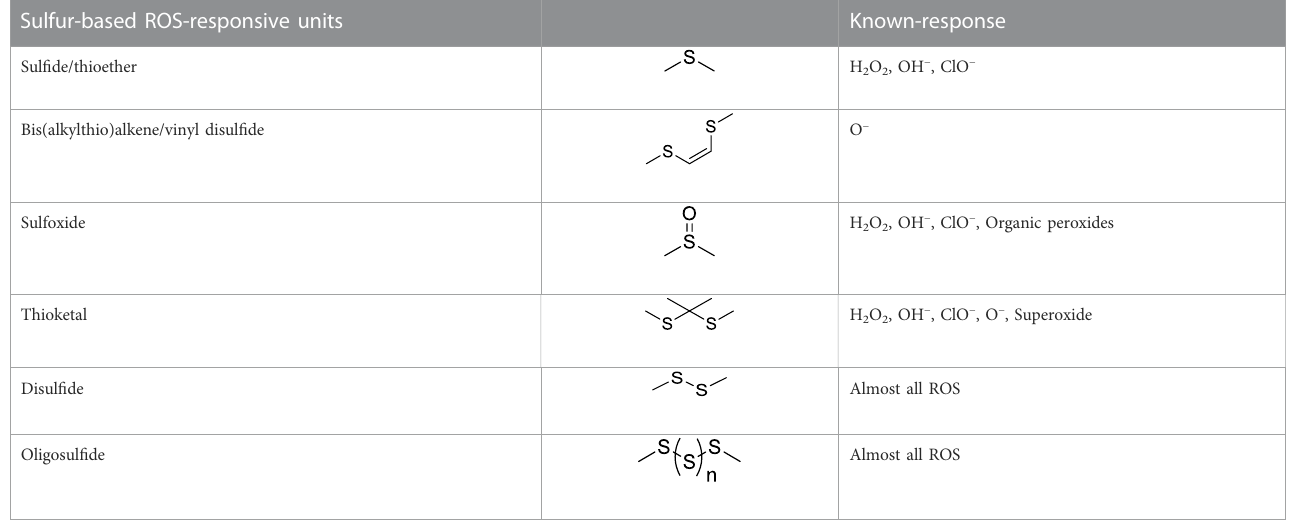
TABLE 2 Chemical structures of the sulfur-based units. Sulfur-based ROS-responsive